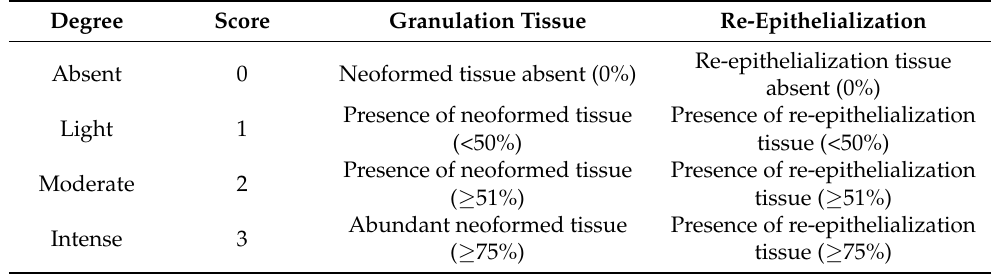
Table 3. Grading scale of proliferative parameters